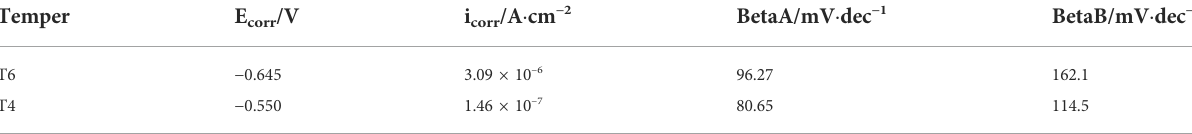
TABLE 2 Electrochemical parameters obtained by Tafel fi tting of polarization curves of the 2060-T4 and 2060-T6 Al-Li alloys.